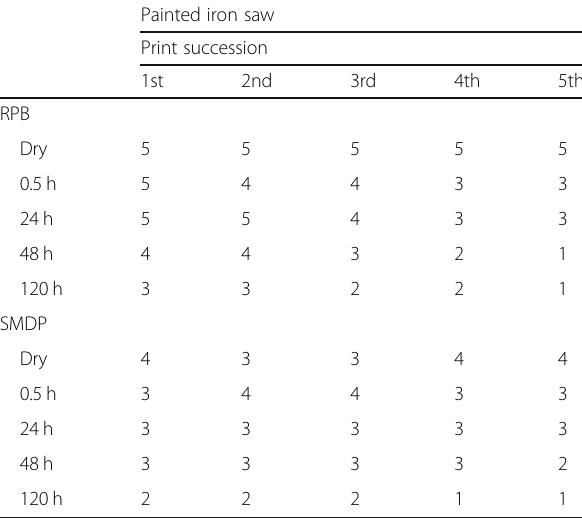
Table 6 Development of submerged and successive prints on debit card (red) using Robin powder blue and Silver magnetic dual powder